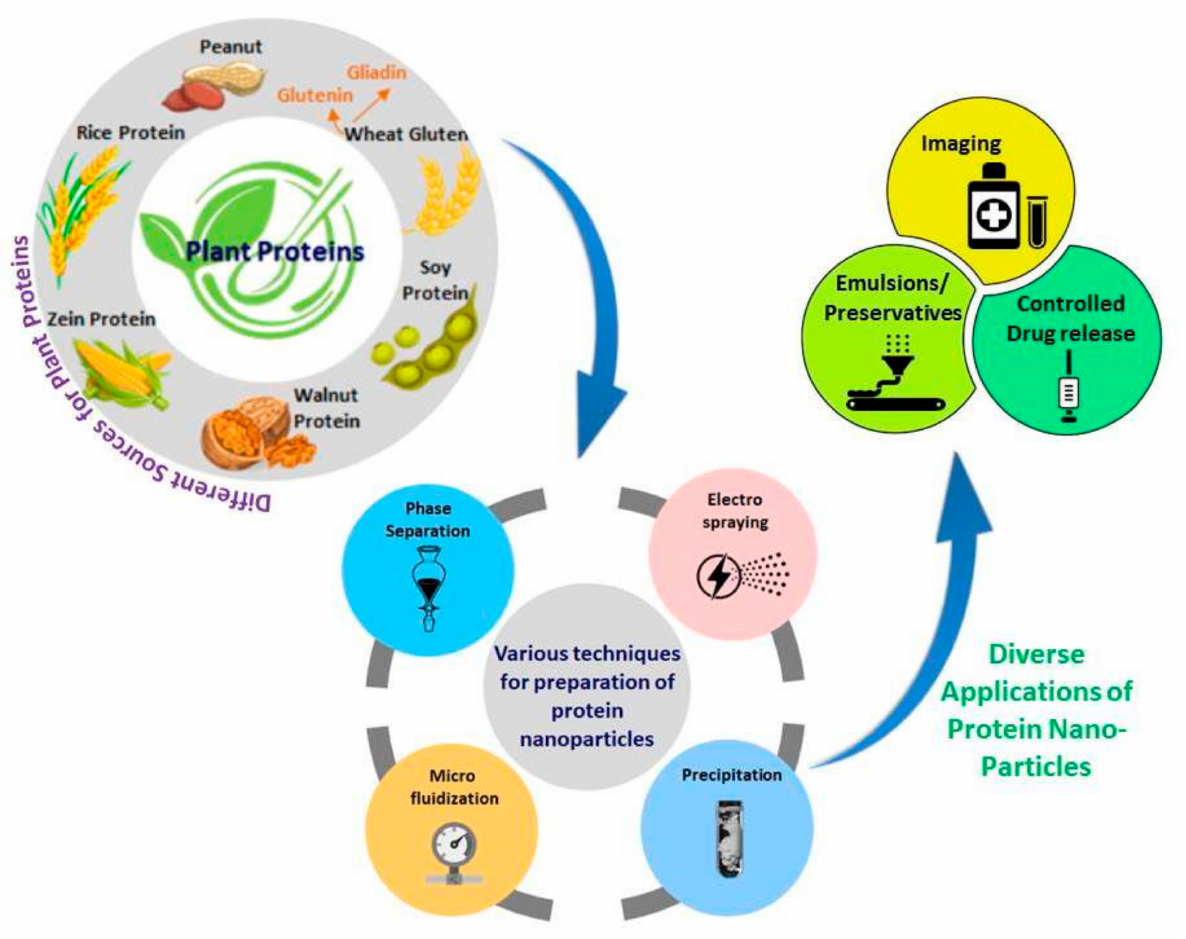
Figure 1. An overview of the sources used, preparation methods, and potential applications of nanoparticles from plant